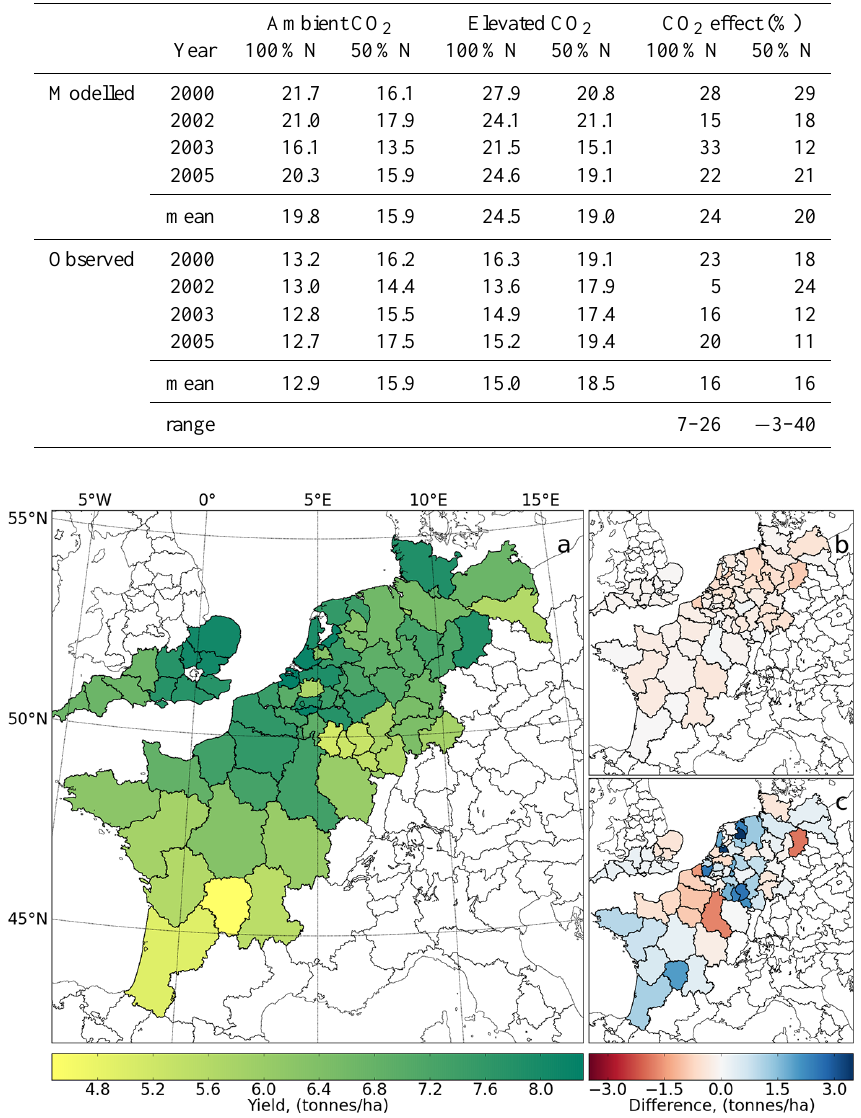
Table 4. Comparison of modelled and observed grain C : N from a FACE experiment where wheat was grown in ambient CO 2 ( ∼ 378ppm) and elevated CO 2 ( ∼ 548ppm). The observed C : N were compiled using Tables 4 and 5 in Weigel and Manderscheid (2012), observed C values were derived from dry matter using the conversion described in Sect. 3.5. The range of the observed CO 2 effect is estimated from the standard errors listed in Tables 4 and 5 in Weigel and Manderscheid (2012).